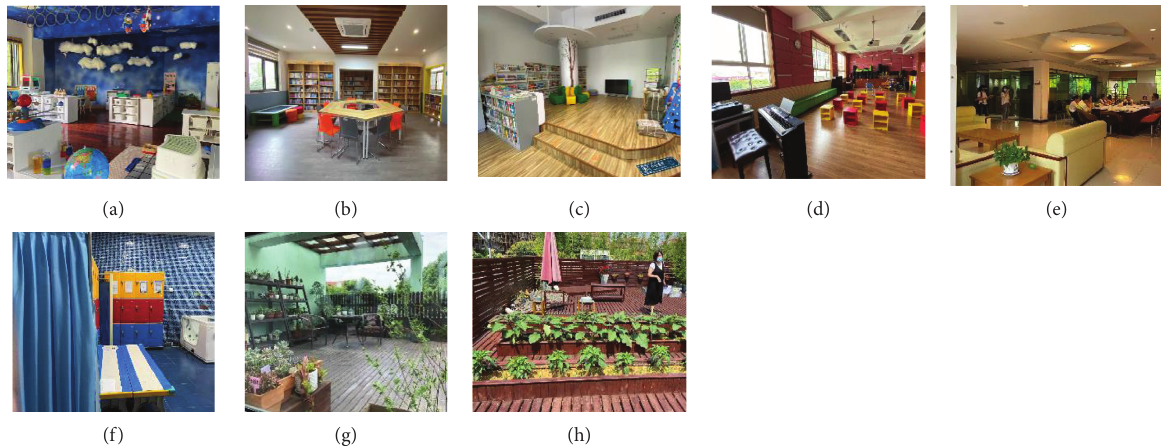
Figure 16: Function and space expansion (photo taken by the author): (a) game room; (b) library communication area; (c) picture book room; (d) music room performing area; (e) integrated area; (f) hydrotherapy room storage space; (g) horticultural rest area; (h) rooftop gardening